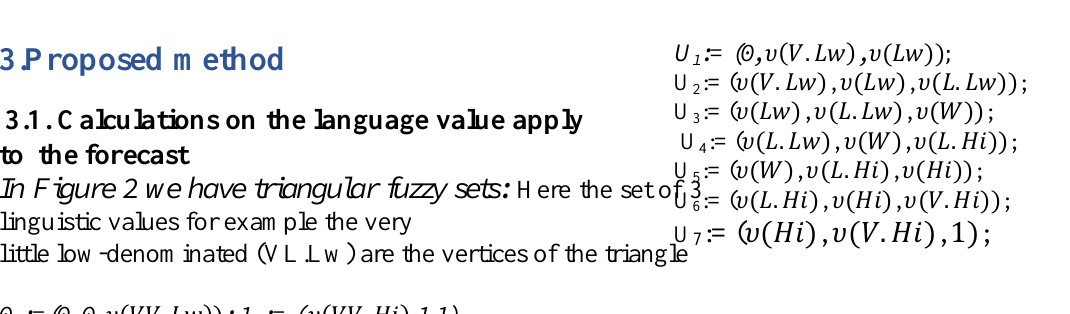
Figure 2. Shown identify the similar fuzzy space  g(x) and U are These are triangular fuzzy sets that represent their membership level function i according to expression